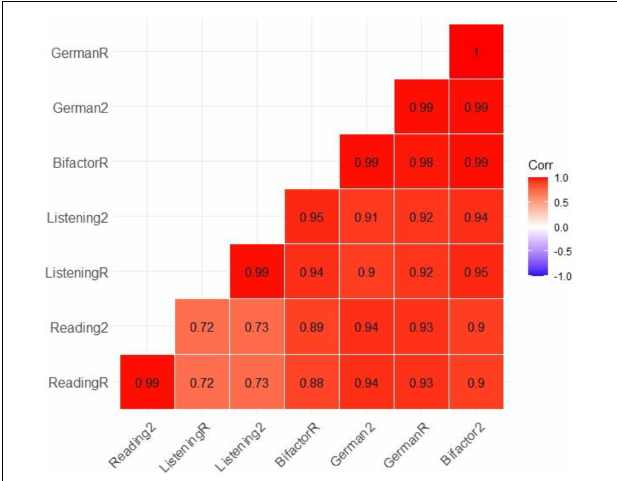
FIGURE 8 | Pearson correlations between subtest scores and German test scores have been estimated using the MAP method. This matrix included only the correlation between the general